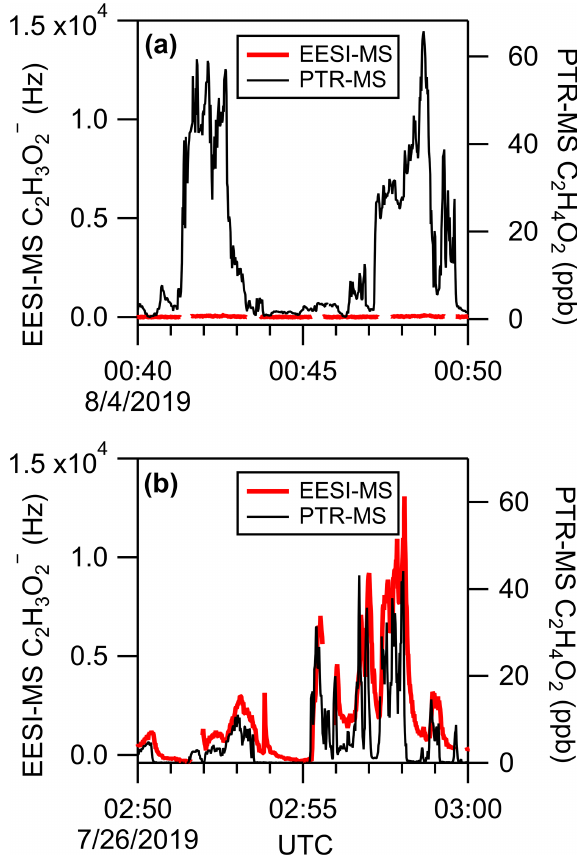
Figure 2. Demonstration of EESI-MS denuder efficiency for re- moving gas-phase VOCs. (a) EESI( − ) acetate signal during wildfire smoke sampling with the carbon denuder in the inlet and (b) with no denuder in place. Comparisons to PTR-MS measurements of C 2 H 4 O 2 (predominantly acetic acid) are included to show that sim- ilar concentrations of gas-phase acetic acid were sampled in both flight segments. The same figure in (a) with a different Y scaling that shows all the detail of the EESI( − ) acetate signal is shown in Fig.